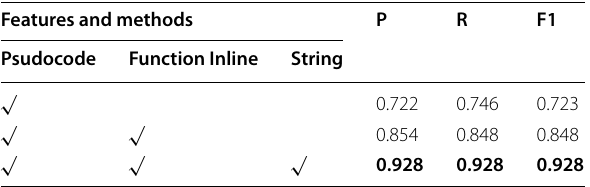
Table 7 The semantic classification results of UPPC using different features and their